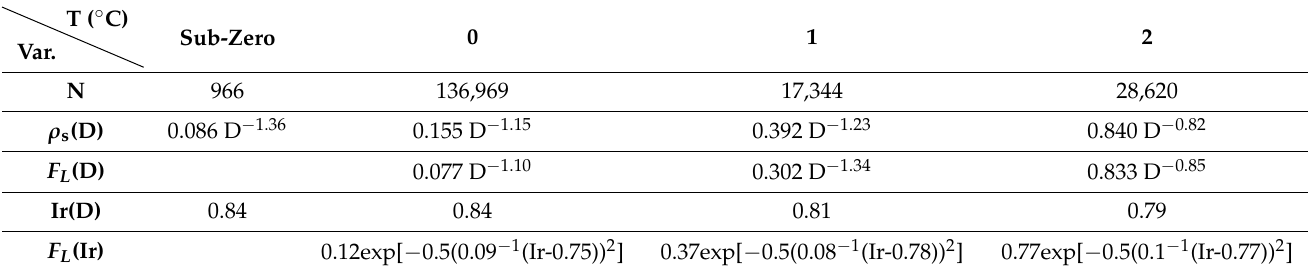
Table 4. Relationships of the physical variables with the temperature. N denotes the number of snow particles.